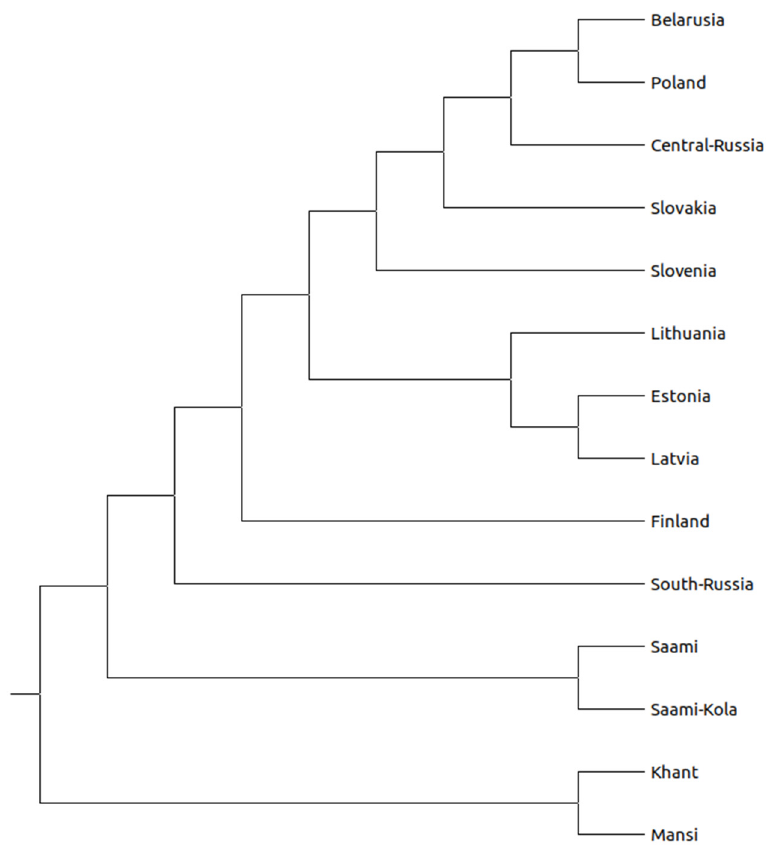
Figure 3. The evolutionary relationship based on the divergence time between populations was inferred using the UPGMA method. The analysis was conducted in MEGA X [19].